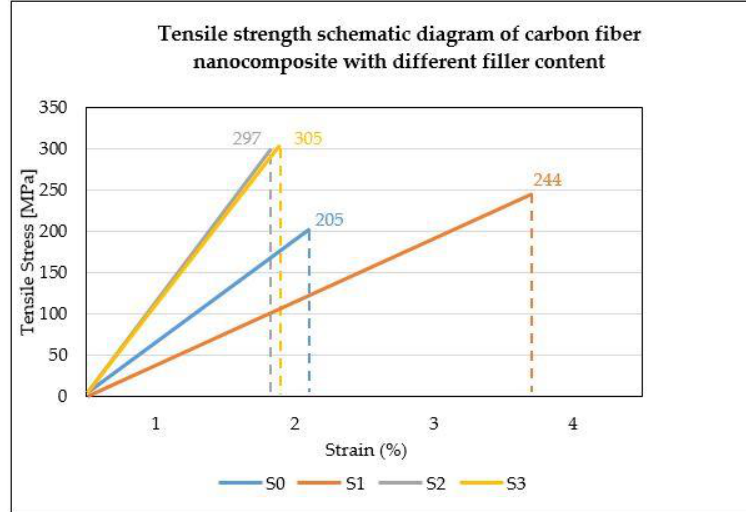
Figure 5. Tensile strength. Table 10. Results of tensile tests.